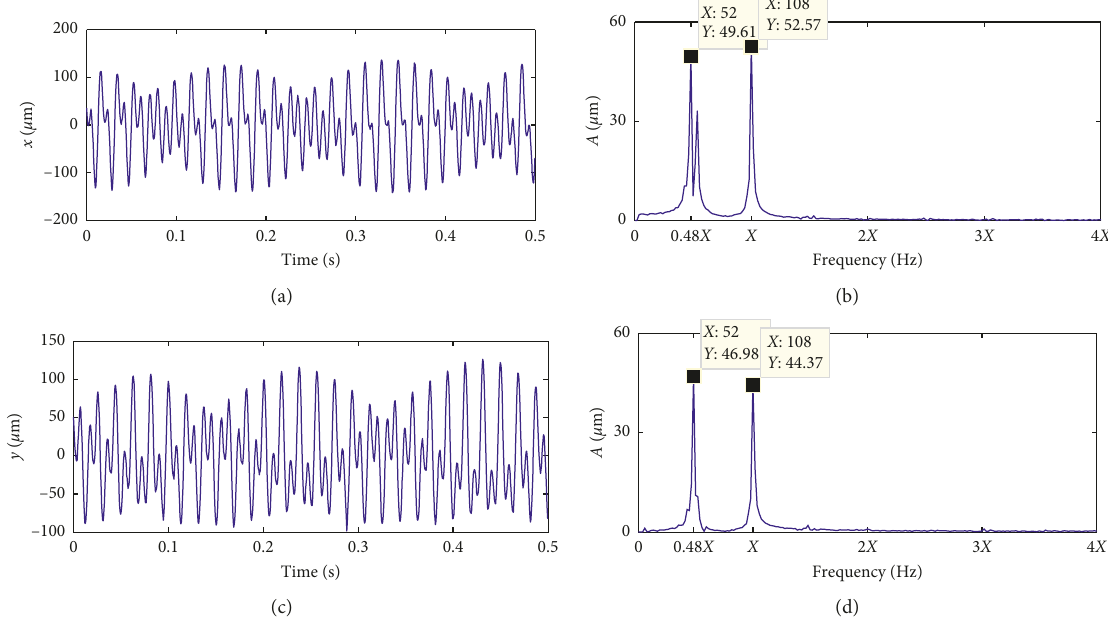
Figure 4: The oil film oscillation signal: (a) the horizontal and vertical direction signals x ; (b) the Fourier spectrum of signal x ; (c) the vertical direction signals y ; (d) the Fourier spectrum of signal y